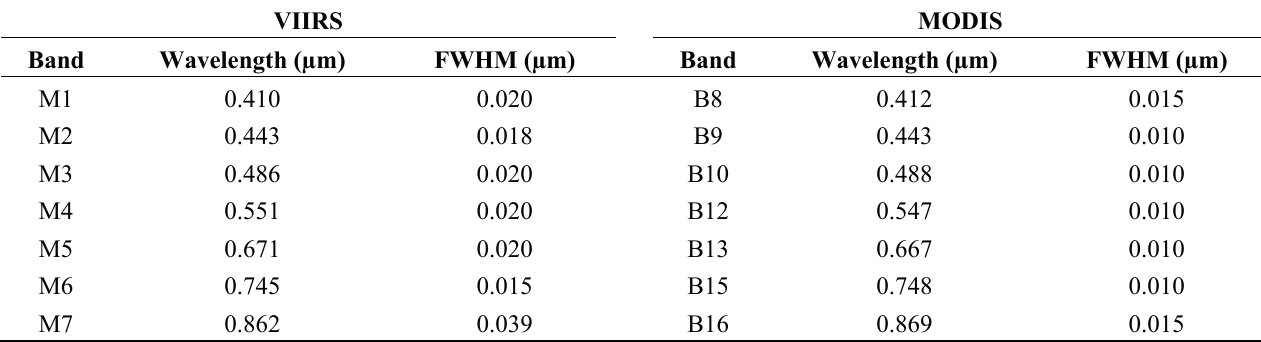
Table 1. The VIIRS VisNIR band names, positions, full widths at half maximum (FWHMs), and characteristics of the corresponding MODIS ocean color